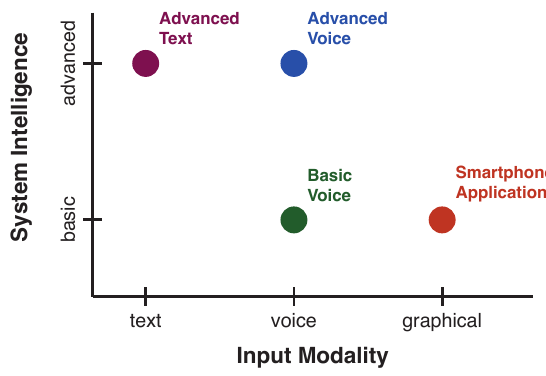
Figure 1. Overview of systems for the interaction with the smart office prototype.